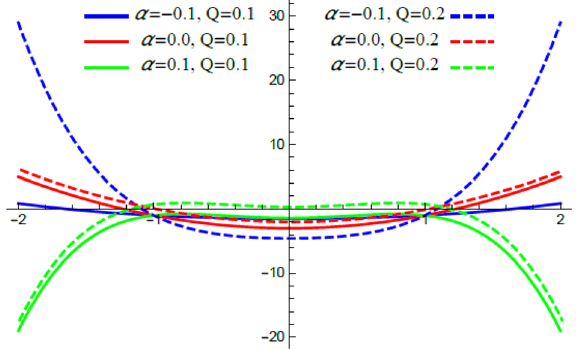
Figure 24. Velocity profile as appeared in Ref. 20 in the case of Gr = 0, R = 0, R d = 0